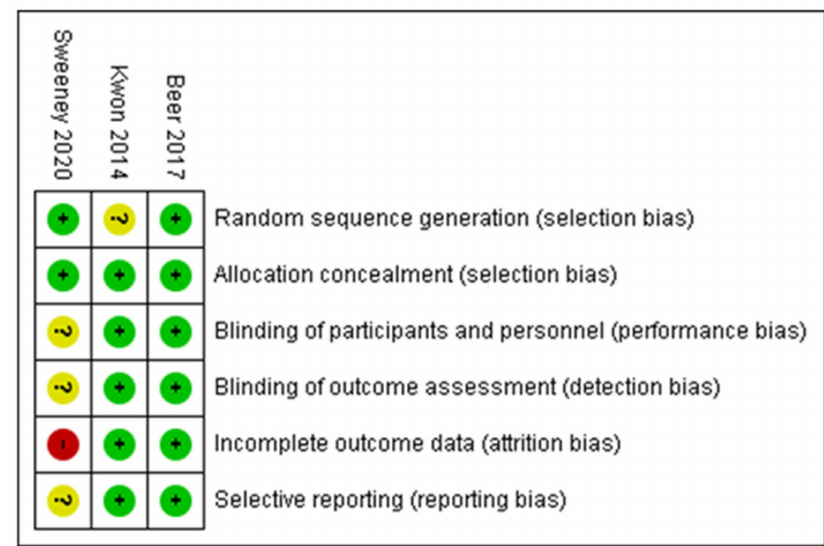
Figure 2. Risk of bias in the randomized trials (green = low risk, yellow = unclear, red = high risk). Sweeney et al., 2020 [25], Kwon et al., 2014 [24], Beer et al., 2017 [23].